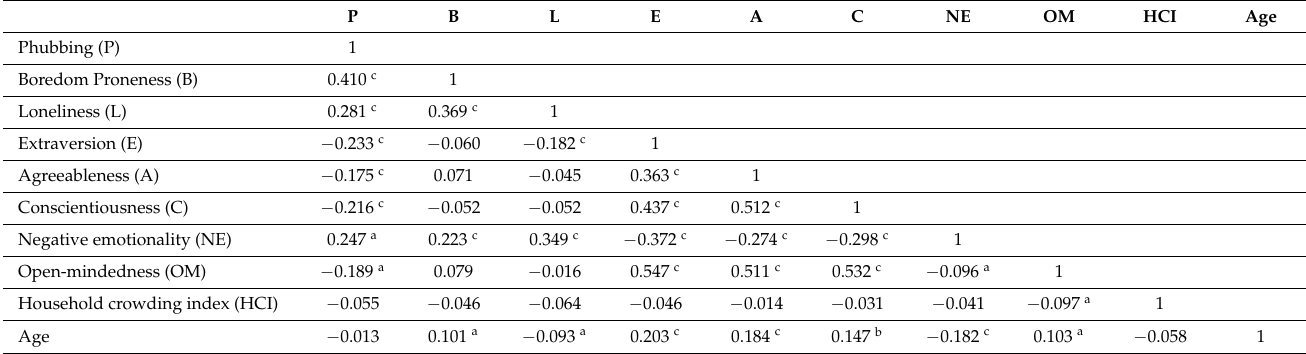
Table 3. Correlation matrix between the variables.